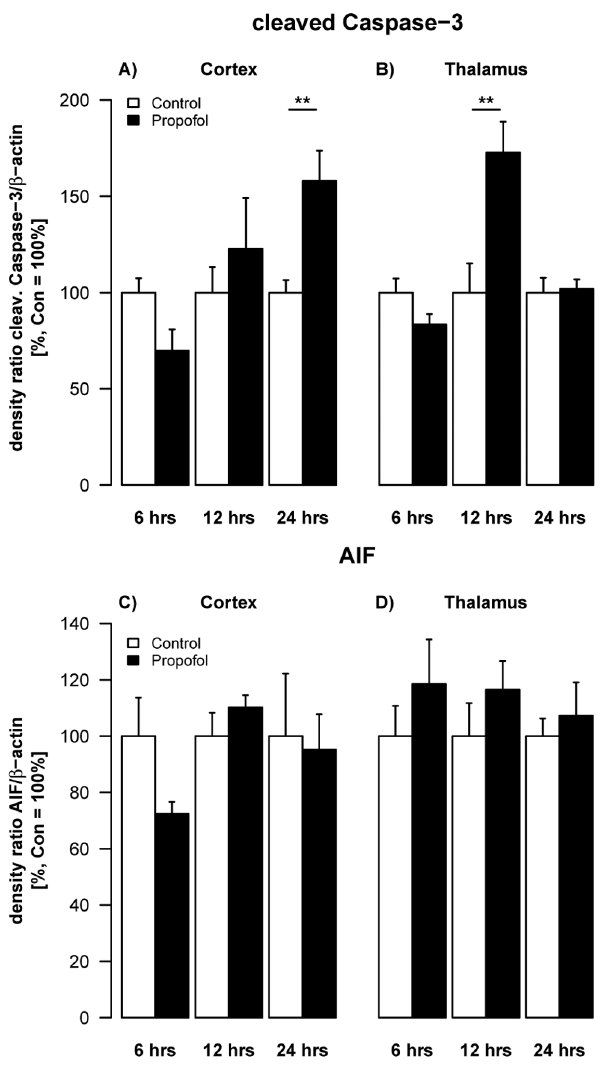
Figure 2. Impact of propofol on neurotrophins. Densitometric quantifications of mRNA levels of BDNF and NT-3 in cortex and thalamus of P6 rats, analysed by qRT-PCR. Values represent mean normalised ratios of the densities of BDNF and NT-3 bands compared to the density of the control group (n=6–7/point + SE). There was an effect of propofol treatment with a decrease of BDNF levels over time, which was significant after 6 hrs in the cortex [F(1,30)=66.5, p , 0.001]. There was also a decrease in NT-3 levels, which was significant in the